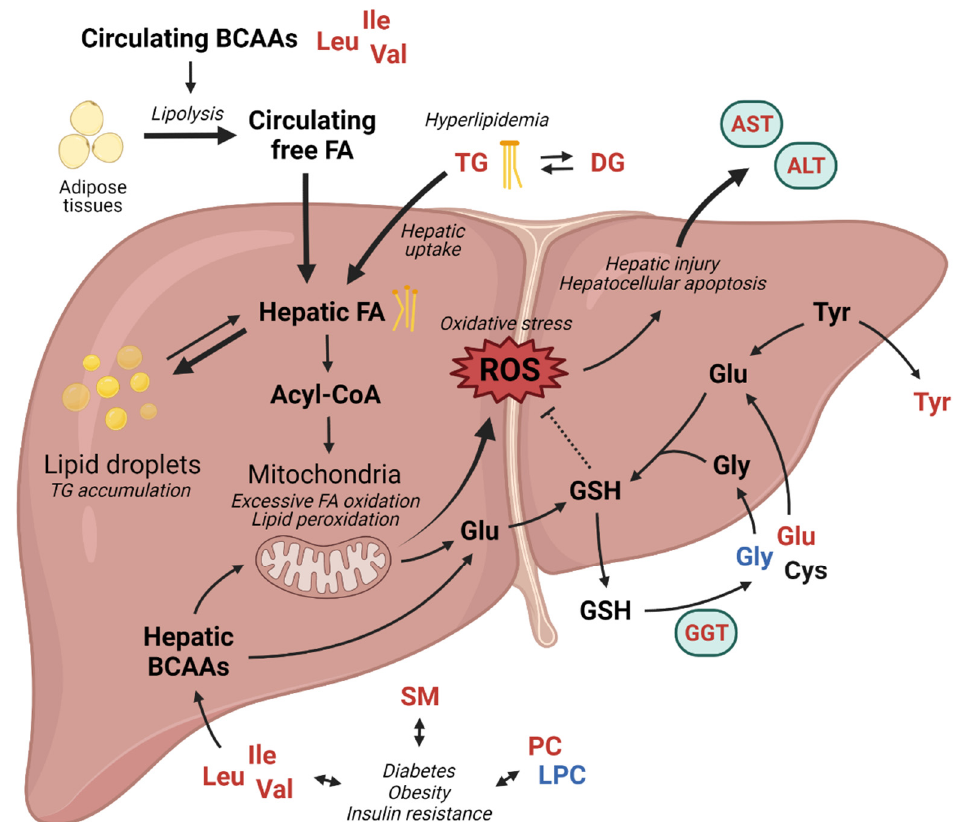
Figure 5. Alterations of metabolic pathways reflecting pathophysiology of NAFLD in overweight pediatric patients. Red: increased level or activity in NAFLD group; Blue: decreased level or activity in NAFLD group. Created with BioRender.com. Abbreviations: NAFLD, nonalcoholic fatty liver disease; BCAAs, branched-chain amino acids; Leu, leucine; Ile, isoleucine; Val, valine; FA, fatty acid; TG, triglyceride; DG, diglyceride; AST, aspartate aminotransferase; ALT, alanine aminotransferase; ROS, reactive oxygen species; Glu, glutamic acid; GSH, glutathione; GGT, gamma-glutamyl transferase; Gly, glycine; Tyr, tyrosine; Cys, cysteine; SM, sphingomyelin; PC, phosphatidylcholine; and LPC, lysophosphatidylcholine.